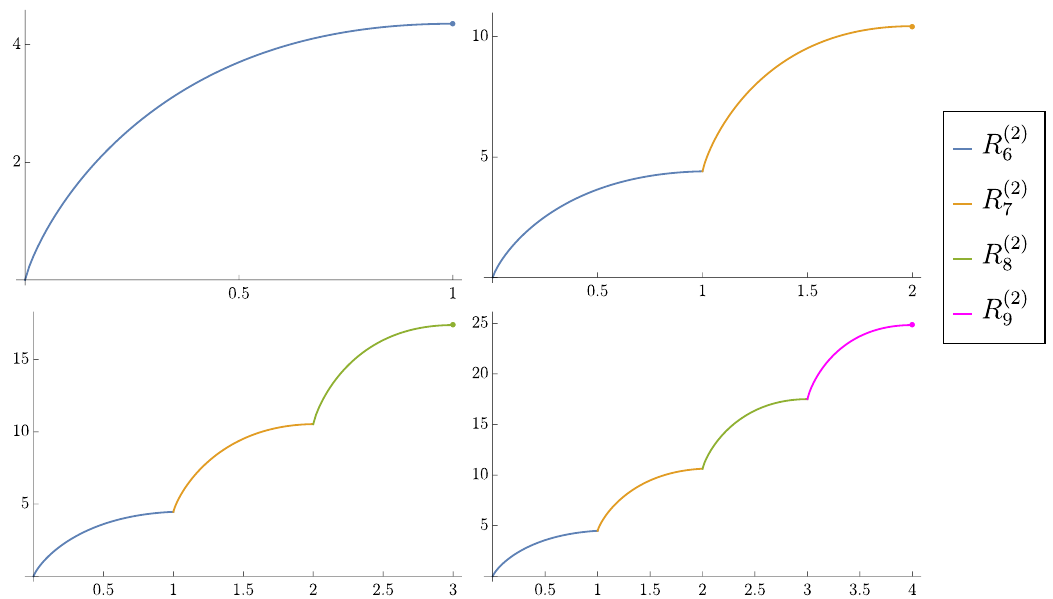
Figure 2. The remainder function evaluated at the dihedrally-symmetric point in six- through nine-particle kinematics and then iteratively taken into collinear limits using the parametrization given in